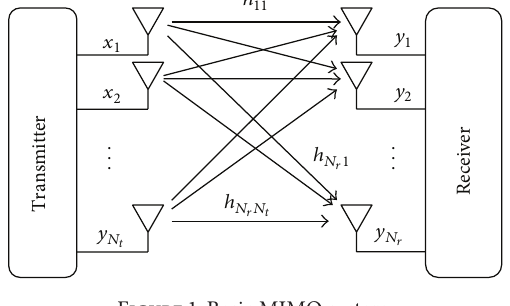
Figure 1: Basic MIMO